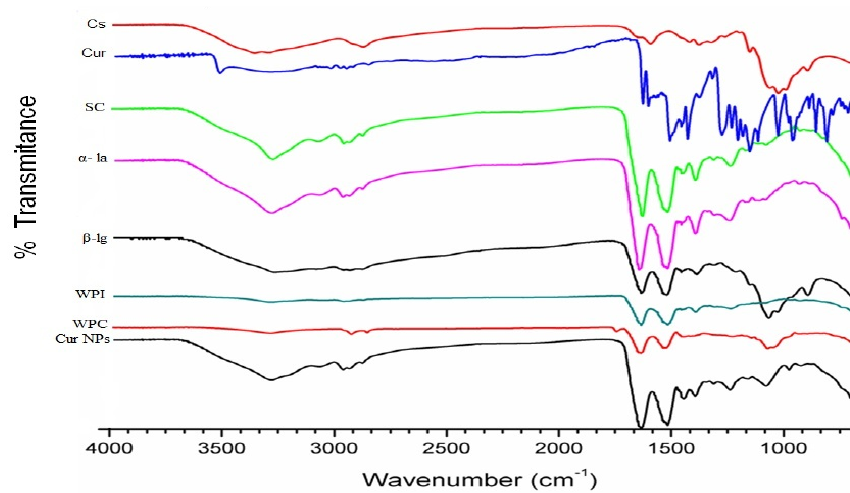
Figure 1. Fourier-transform infrared (FTIR) spectra of chitosan (Cs), curcumin (Cur), Sod. caseinate (SC), α-lactalbumin (α-La), β-lactoglobulin (β-lg), whey protein isolate (WPI), whey protein concentrate (WPC) and curcumin loaded nanoparticles (Cur NPs).